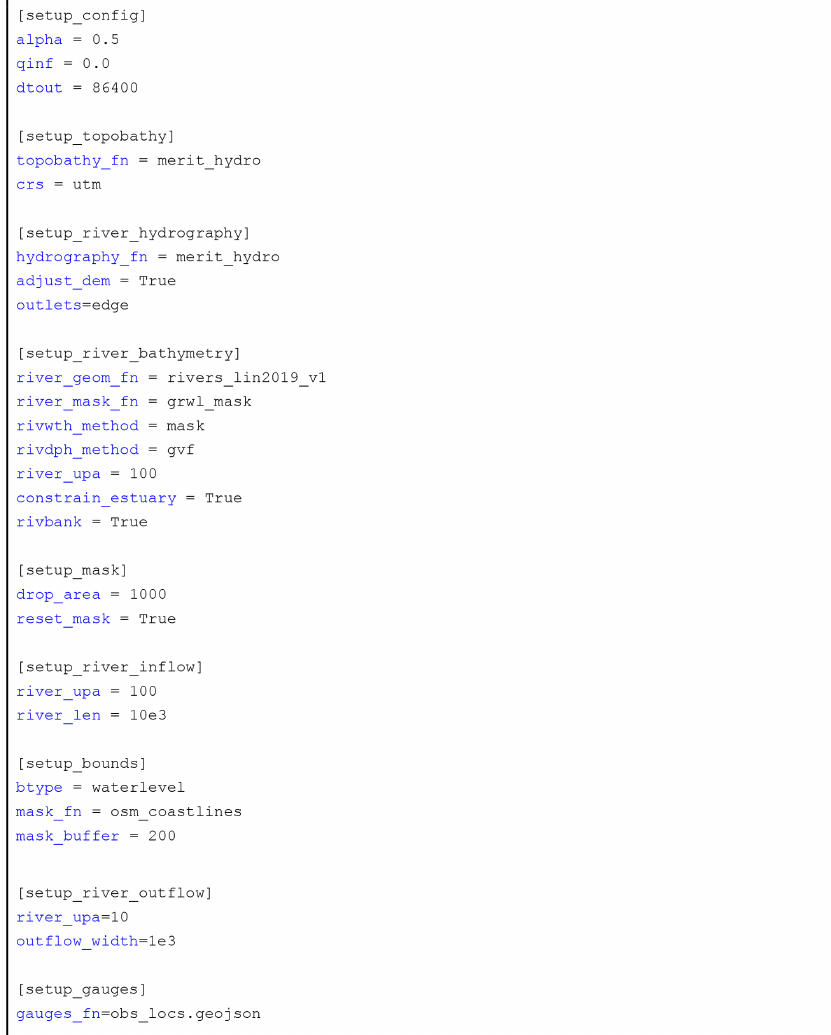
Figure B1. Example HydroMT-SFINCS configuration file used to set up the SFINCS model schematization (see Sect. 3.2.1). Each section corresponds to a step in the automatic model-building process. Options ending with _fn (filename) correspond to data from the data catalog; see Table